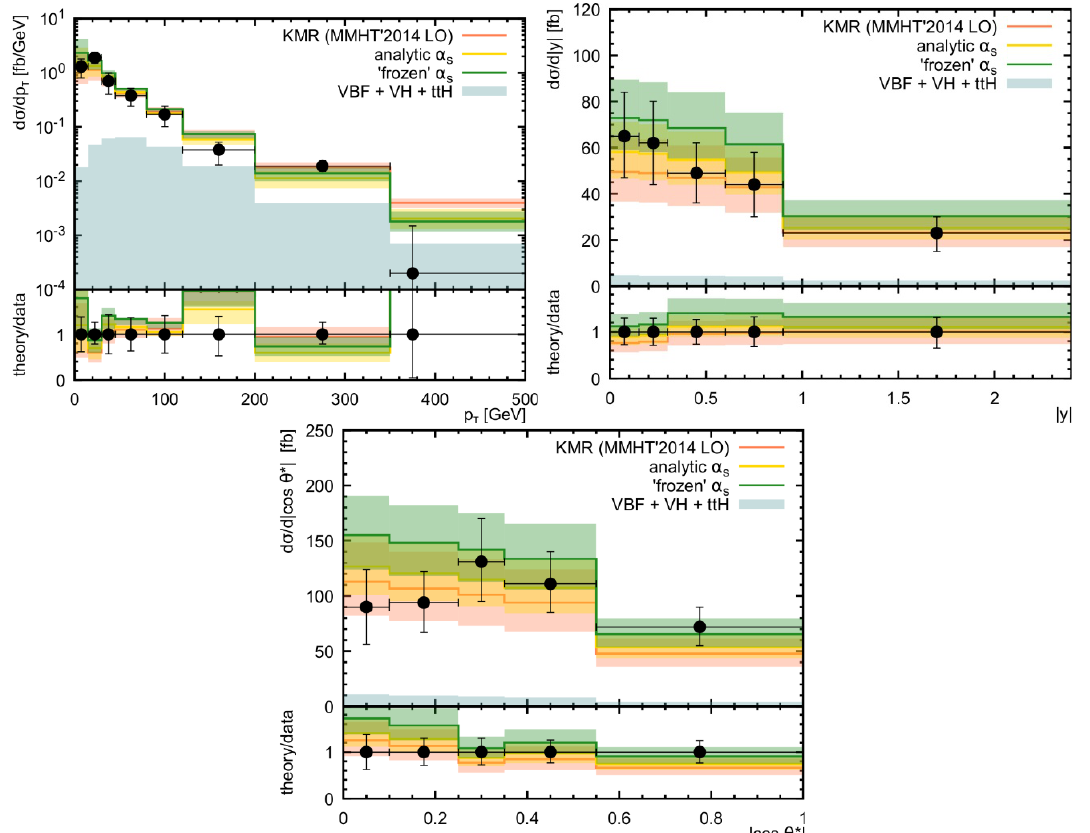
Figure 6 . The di(cid:11)erential cross sections of inclusive Higgs boson production (in the diphoton decay p mode) at s = 13 TeV as functions of diphoton pair transverse momentum p (cid:13)(cid:13) photon helicity angle cos (cid:18) (cid:3) (in the Collins-Soper frame). The experimental data are from CMS